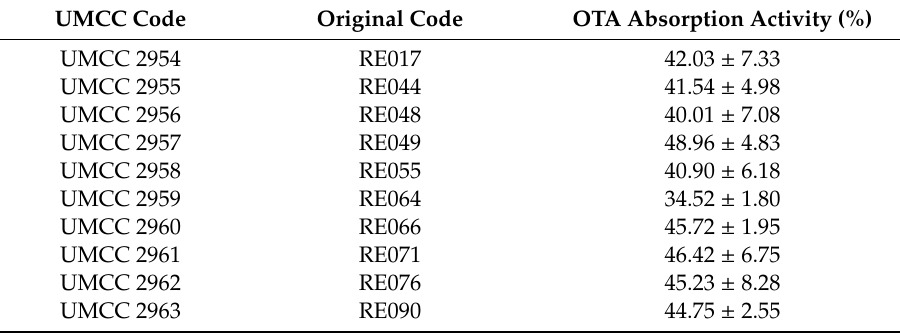
Figure 3. Fermentative vigour of the S. cerevisiae strains for which OTA reduction activity was detected. Different superscript letters within the column indicate significant differences in data set according to one-way ANOVA and Tukey’s HSD post hoc test tests at p < 0.05. Bars indicate ± standard deviation. Table 3. S. cerevisiae strains deposited in Unimore Microbial Culture (UMCC) and their OTA absorption